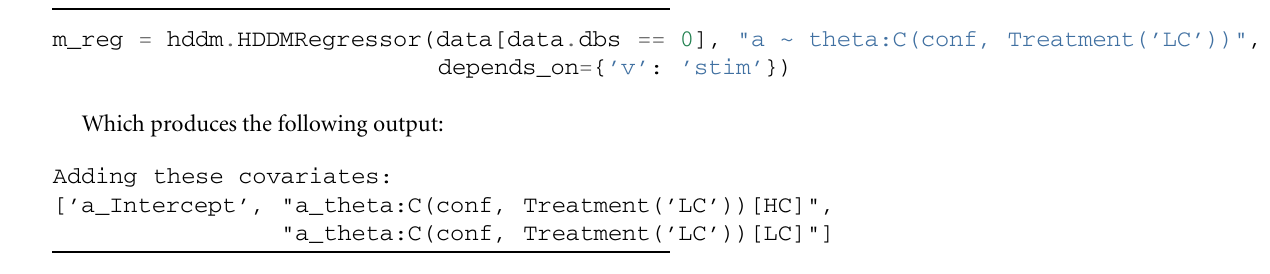
As noted above, this experiment also tested patients on deep brain stimulation (DBS). Figure 5 shows the regression coeffi- cient of theta on threshold when the above model is estimated in the DBS off condition (in blue) and the DBS on condition (in green; code to estimate not shown). As can be seen, the influ- ence of theta on threshold reverses. This exercise thus shows that HDDM can be used both to assess the influence of trial-by-trial brain measures on DDM parameters, but also how parameters vary when brain state is